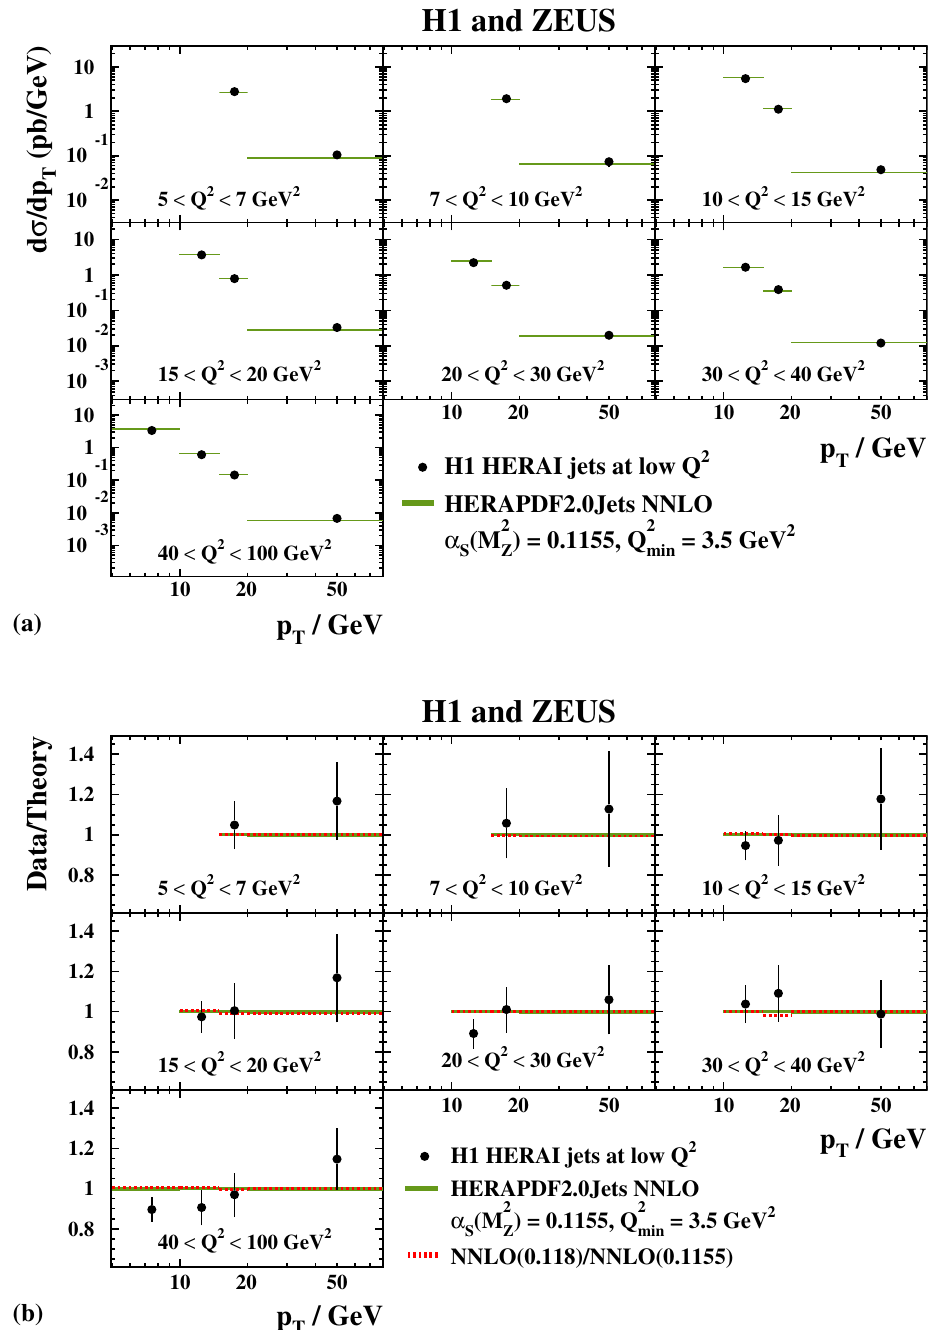
Fig. 13 a Differential jet-cross-section predictions, d σ/ d p T , based onthepredictionsexcludingscaleuncertainties;thebandsaresonarrow ) = 0 . 1155 in bins of Q 2 on HERAPDF2.0Jets NNLO with α s ( M 2 thattheymostlyappearaslines.Errorbarsindicatethefulluncertainties Z on the data and are smaller than the symbols in ( a ). In b , the ratio of between5and100GeV 2 comparedtoH1data[10].Onlydatausedinthe predictions based on HERAPDF2.0Jets NNLO with α s ( M 2 fitareshown. b Measuredcrosssectionsdividedbypredictionsbasedon ) = 0 . 1155 is also HERAPDF2.0Jets NNLO. The bands represent the total uncertainties and α s ( M 2 Z